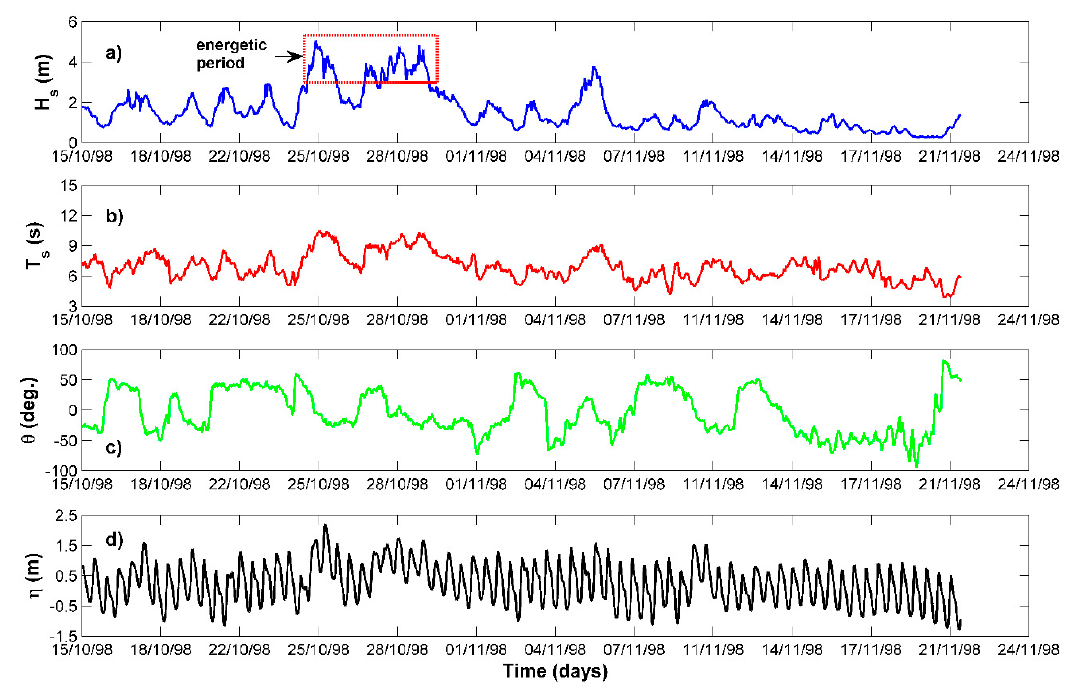
Figure 1. Offshore significant wave height ( a ); wave period ( b ); wave direction ( c ); and tidal level; ( d ) recorded during field measurements at Egmond ann Zee in the Netherlands.